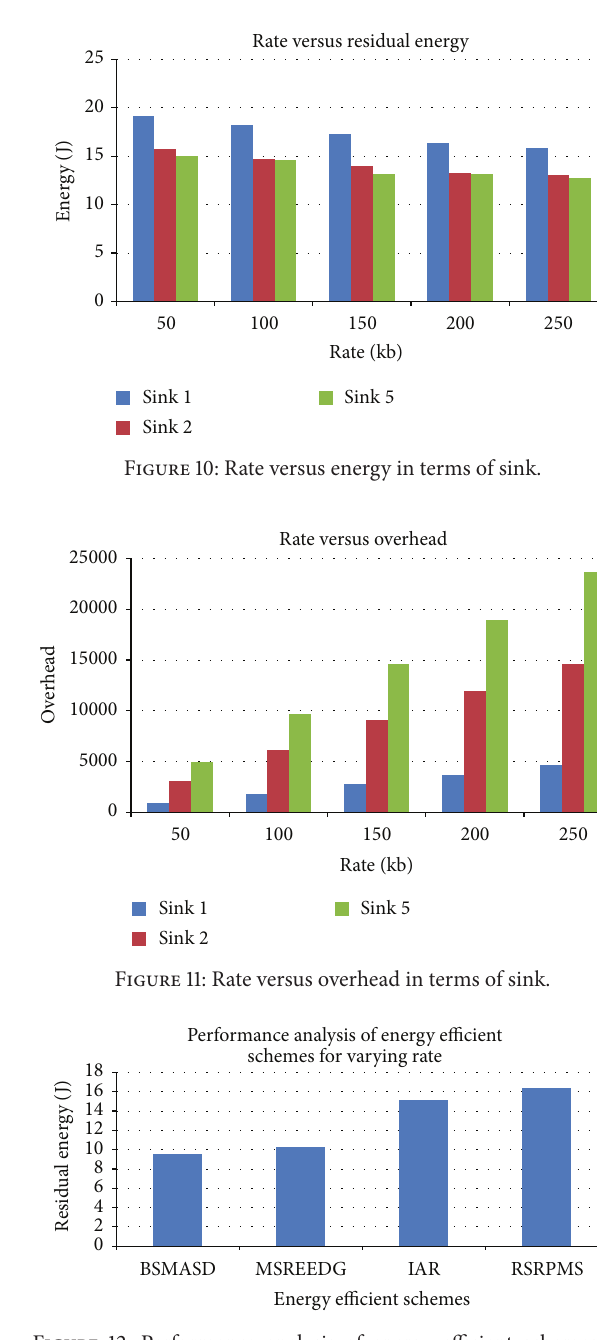
Figure 12: Performance analysis of energy efficient schemes for varying data